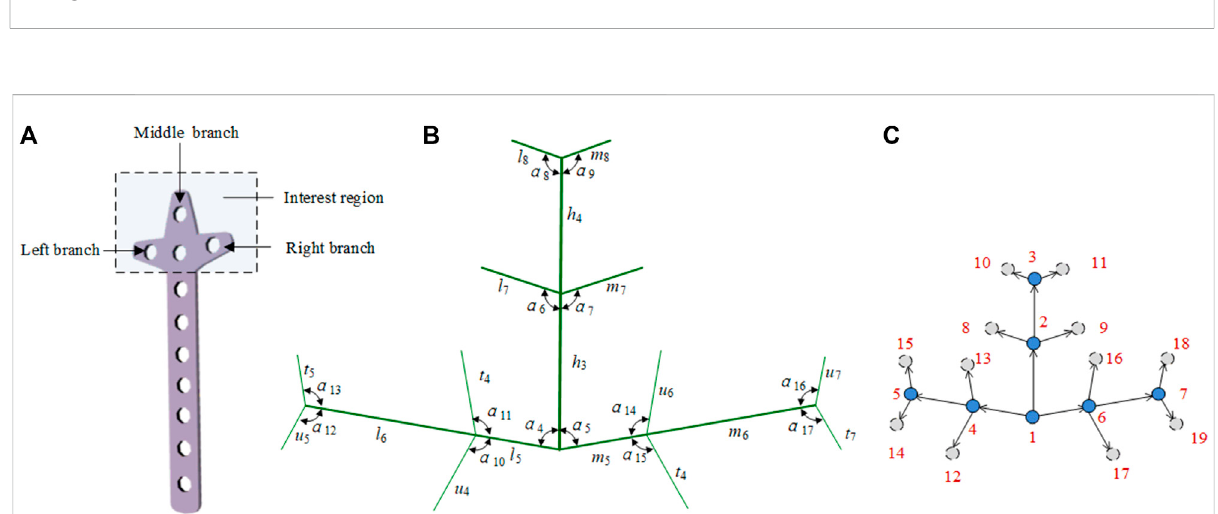
FIGURE 7 Bionic vein structure feature of the clover bone plate. (A) Interest region of the clover bone plate, contains three branches: left branch, middle branch, and right branch. (B) Semantic parameters of the interest region, mainly refers to the length of veins and the angle between veins. (C) Weighted digraph of the interest